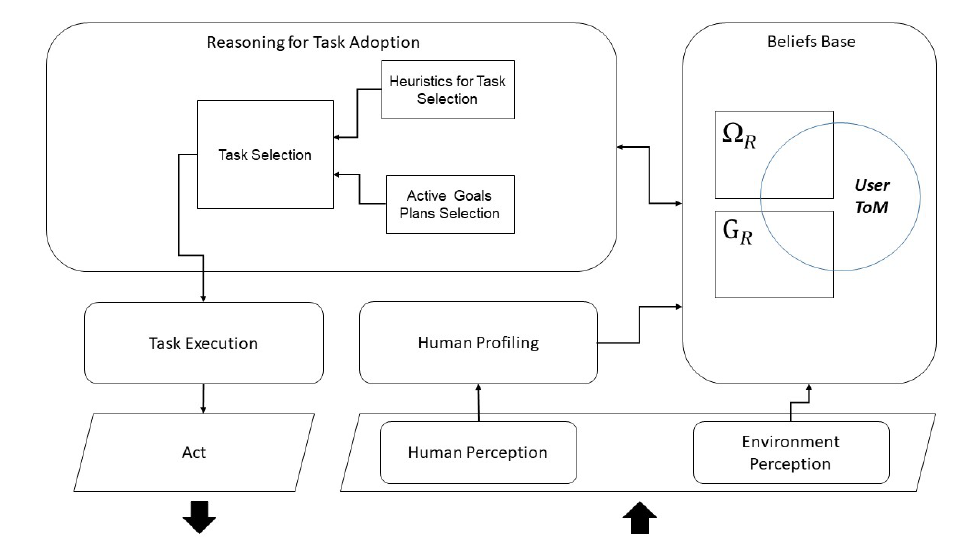
Figure 1. Perception–reasoning–action (PRA) cycle of the cognitive architecture. Please note that every module can manipulate (read or write) G R and Ω R